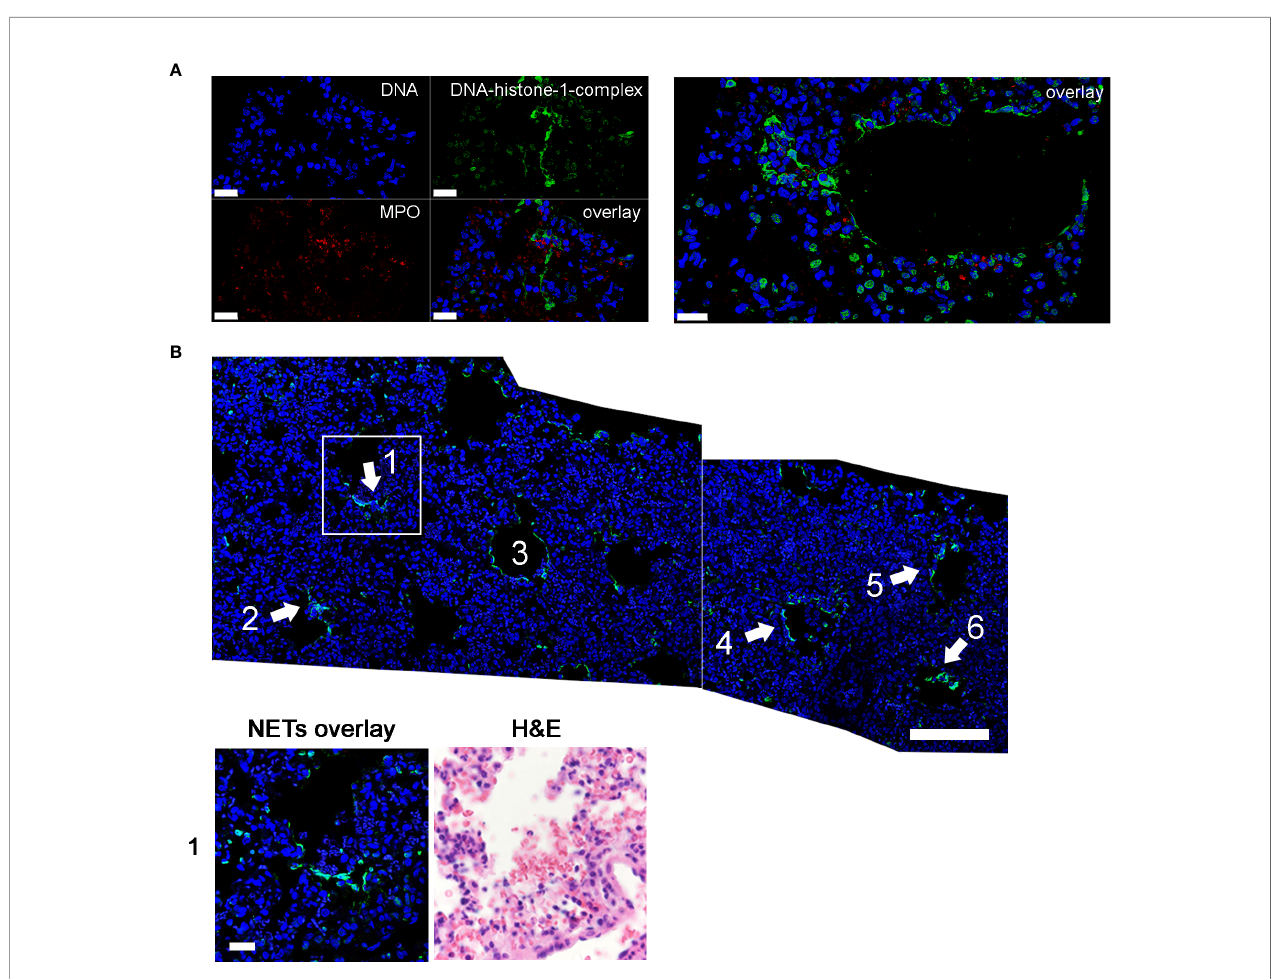
FIGURE 2 | NETs as extracellular DNA- fi bers were detected in lungs of SARS-CoV-2 infected hamsters 3 dpi by confocal immuno fl uorescence microscopy. (A) NETs as extracellular DNA- fi bers were detected 3 dpi in lungs of SARS-CoV-2 infected hamsters. Representative 3D images of z-stacks were constructed with LAS X 3D Version 3.1.0 software (Leica) (upper panel: 3.36 µm consisting of 21 sections, lower panel: 4.25 µm consisting of 25 sections). (B) Stitched images show distribution of NETs (area 1 – 5) in the lung of SARS-CoV-2 infected hamster (blue = DNA, green = DNA-histone-1-complex). A zoom picture of area 1 is presented. Serial cuts were stained for NETs and H&E and allowed identi fi cation of blood vessels. NETs can be found interstitial and intrabronchial. Scale bars: stitched image = 100µm, magni fi cation image = 20 µm. Settings of the immuno fl uorescence microscope were adjusted to a respective isotype